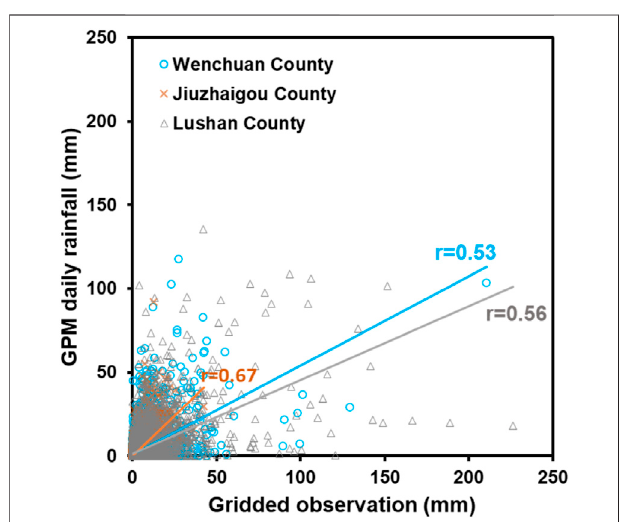
FIGURE 6 | Comparison between GPM daily rainfall data and gridded